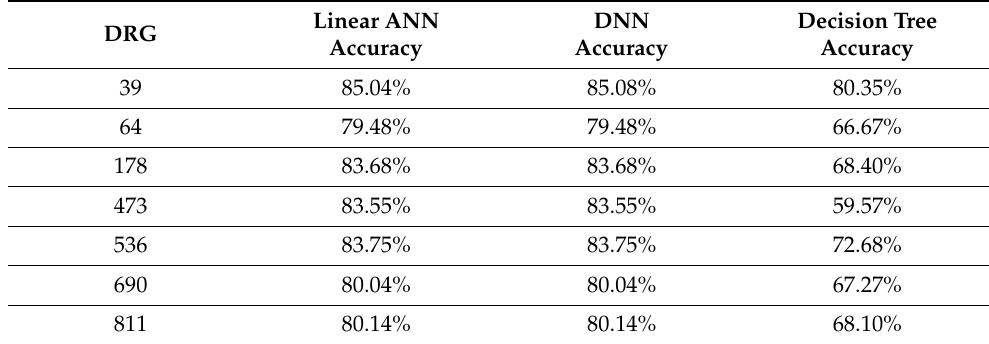
Table 5. Decision Tree results and comparison with Sequential Model and Deep Neural Network. Linear DRG